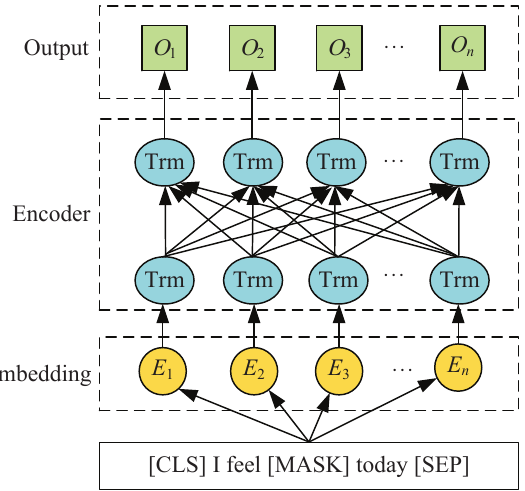
Fig. 2 The overall structure of